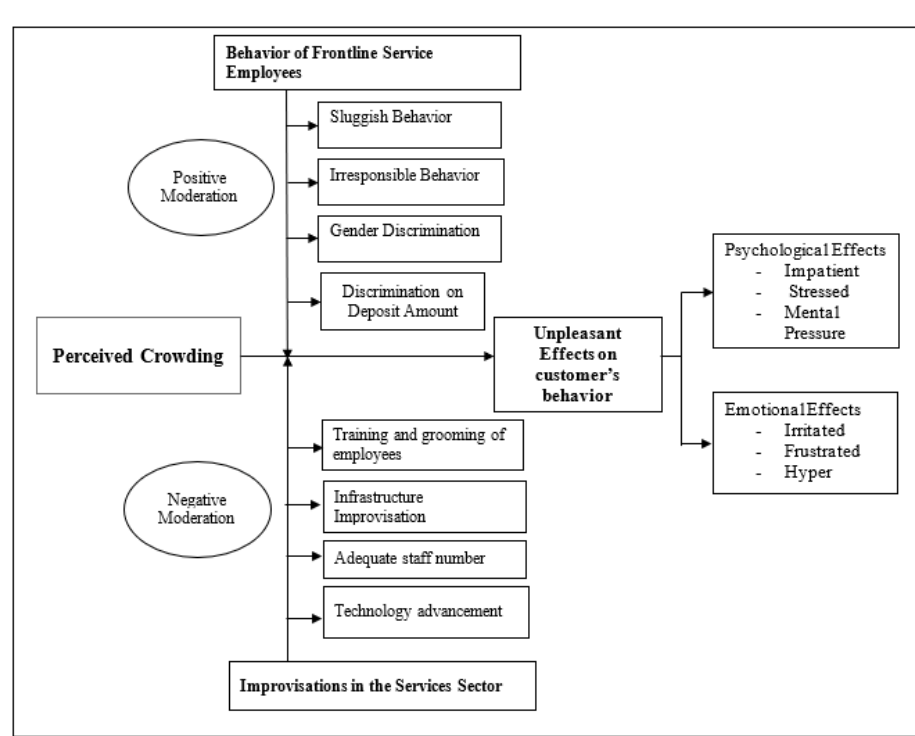
perceived crowding on customers within the services sector. Although multiple types of research are conducted on customer satisfaction, still the literature lacks an understanding of crowding effects in the services